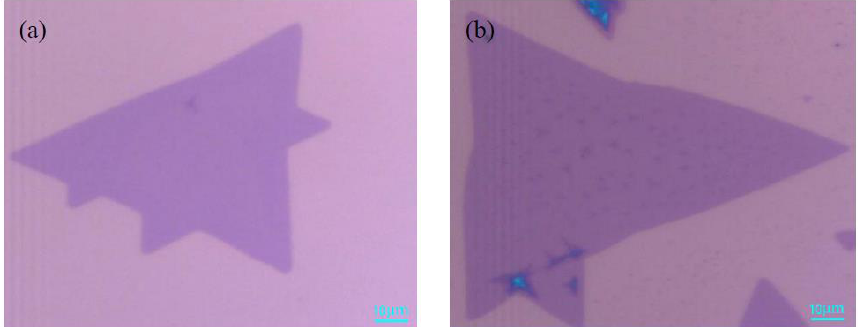
Figure 6. Optical microscope images of two different positions of the same sample ( a ) 80 μm ; ( b ) 100 μm . Scale bar: 10 μm .